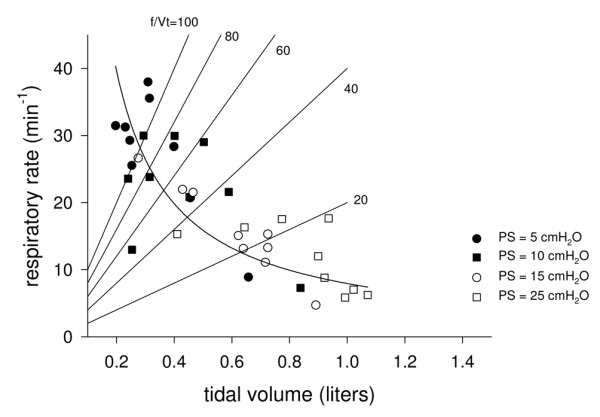
Relationship between Vt and respiratory rate. Shown is the relationship between Vt and respiratory rate (f) in the patients at different levels of pressure support: 5 cmH2O (closed circles), 10 cmH2O (open circles), 15 cmH2O (closed squares) and 25 cmH2O (open squares). The straight lines represent isopleths of different values of f/Vt (20, 40, 60, 80 and 100 l-1·min-1). The curved line is the fitting of data points by the following equation: f = K/Vt (where K = 7.9385 ± 0.4324). PS, pressure support; Vt, tidal volume.